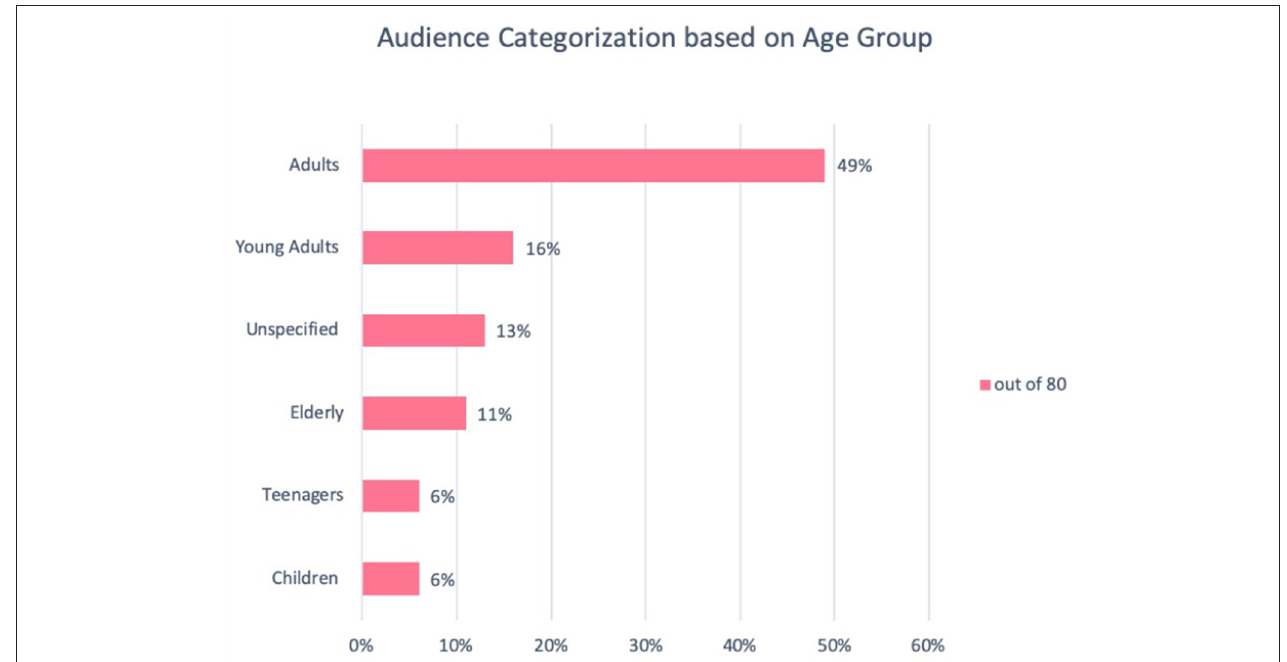
FIGURE 15 | Targeted audience by age demographics.